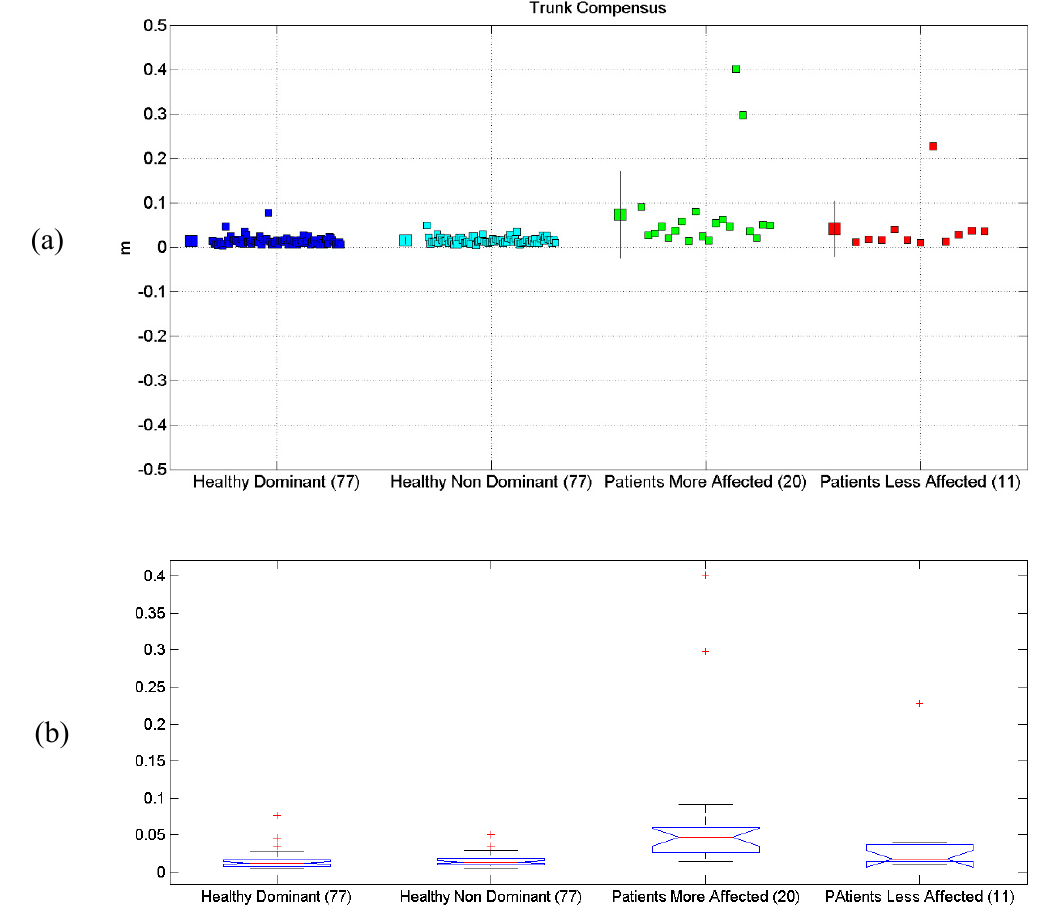
Figure 8. ( a ) Scatterplot for Trunk Compensus for the four considered groups. Mean (SD) of each population (considered limb) are reported. ( b ) Distributions of Trunk Compensus, are shown for the four experimental conditions. The central line indicates the median, while the lower and upper extremities of the boxes represent the 25th and 75th percentiles, respectively. The whiskers comprise all data points of distribution, except the outliers, which are plotted separately using the ‘+’ mark.